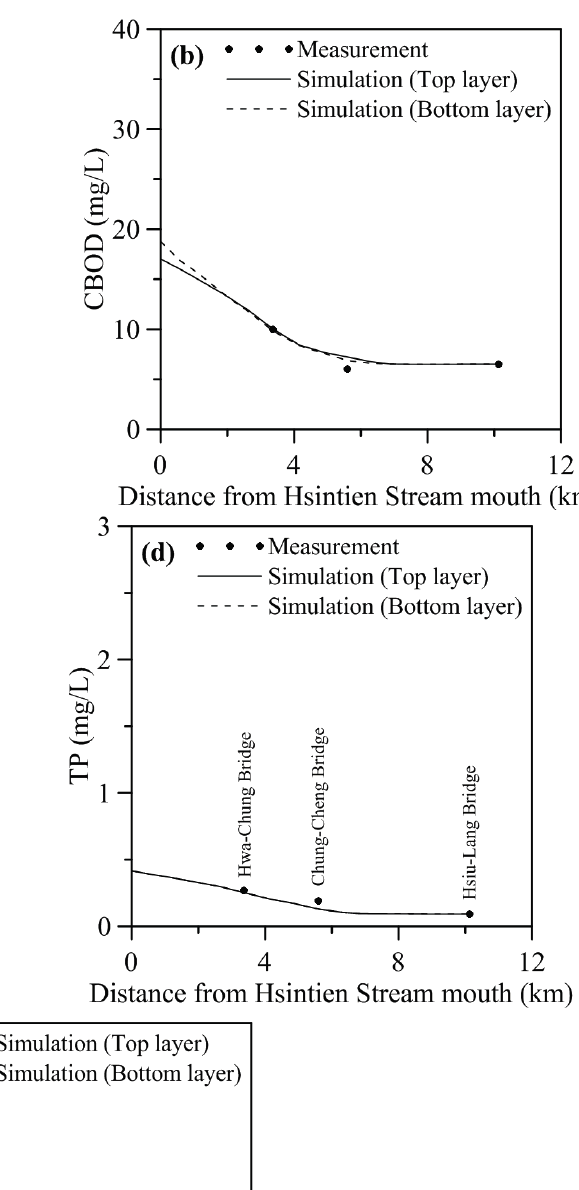
Figure 6. Comparison between measured and simulated water quality distribution along the Hsintien Stream on 1 March 2010: ( a ) DO; ( b ) CBOD; ( c ) NH (simulated result shown only as no NO